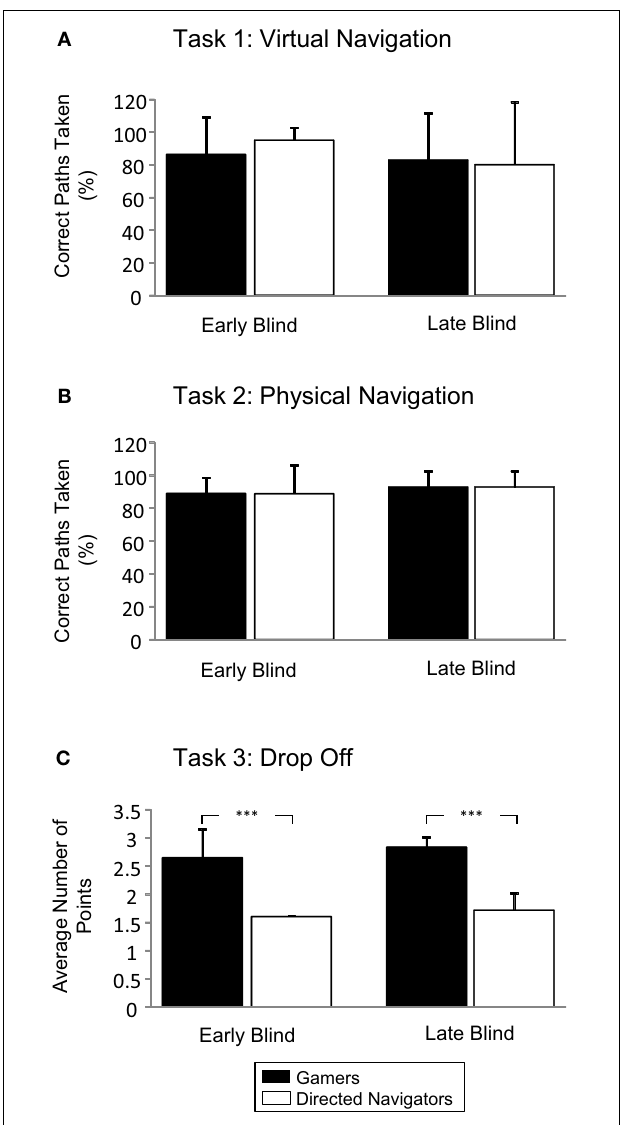
FIGURE 3 | Navigation performance—arriving to target. Comparing performance on navigation tasks between gamers and directed navigator learning strategy in early and late blind participants. (A) High success on correct paths taken (%) for virtual room-to-room navigation was observed in both groups. (B) Similar high transfer success on correct paths taken (%) was observed for physical room-to-room navigation. (C) Results of the drop off task reveal an advantage for gamers. Paths chosen were scored such that the shortest route possible to exit the building from a given starting point received a maximum of 3 points, 2 for next closest exit, 1 for the longest, 0 for unsuccessful. Gamers showed an advantage over directed navigators in that they were more likely to choose the shortest path on the drop off task (indicated by higher average point score). The Three-Way ANOVA revealed a significant main effect for condition (see text). Error bars indicate SD, ∗∗∗ p < 0 . 001.